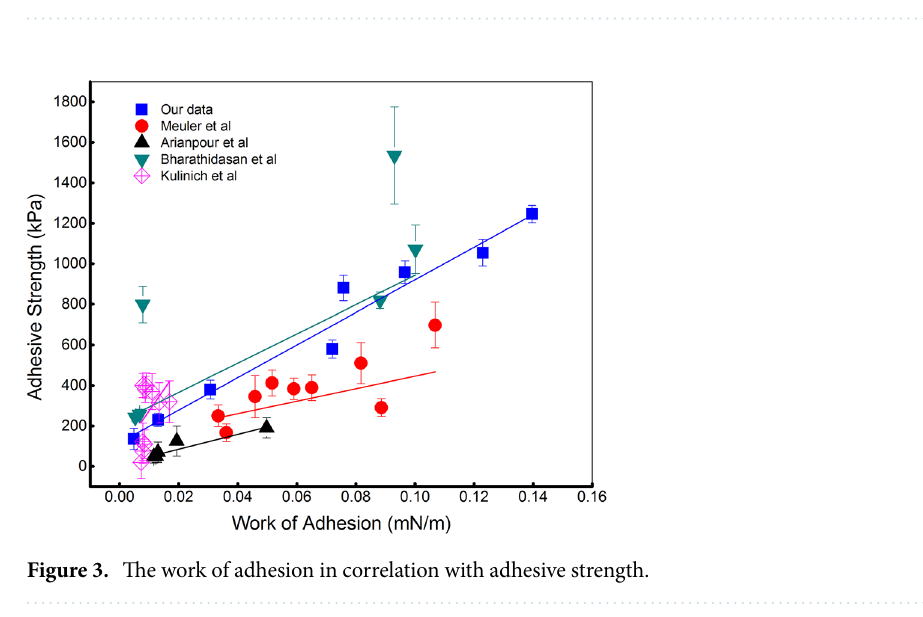
Figure 2. The reduction ratio of adhesion strength to as-received Al.